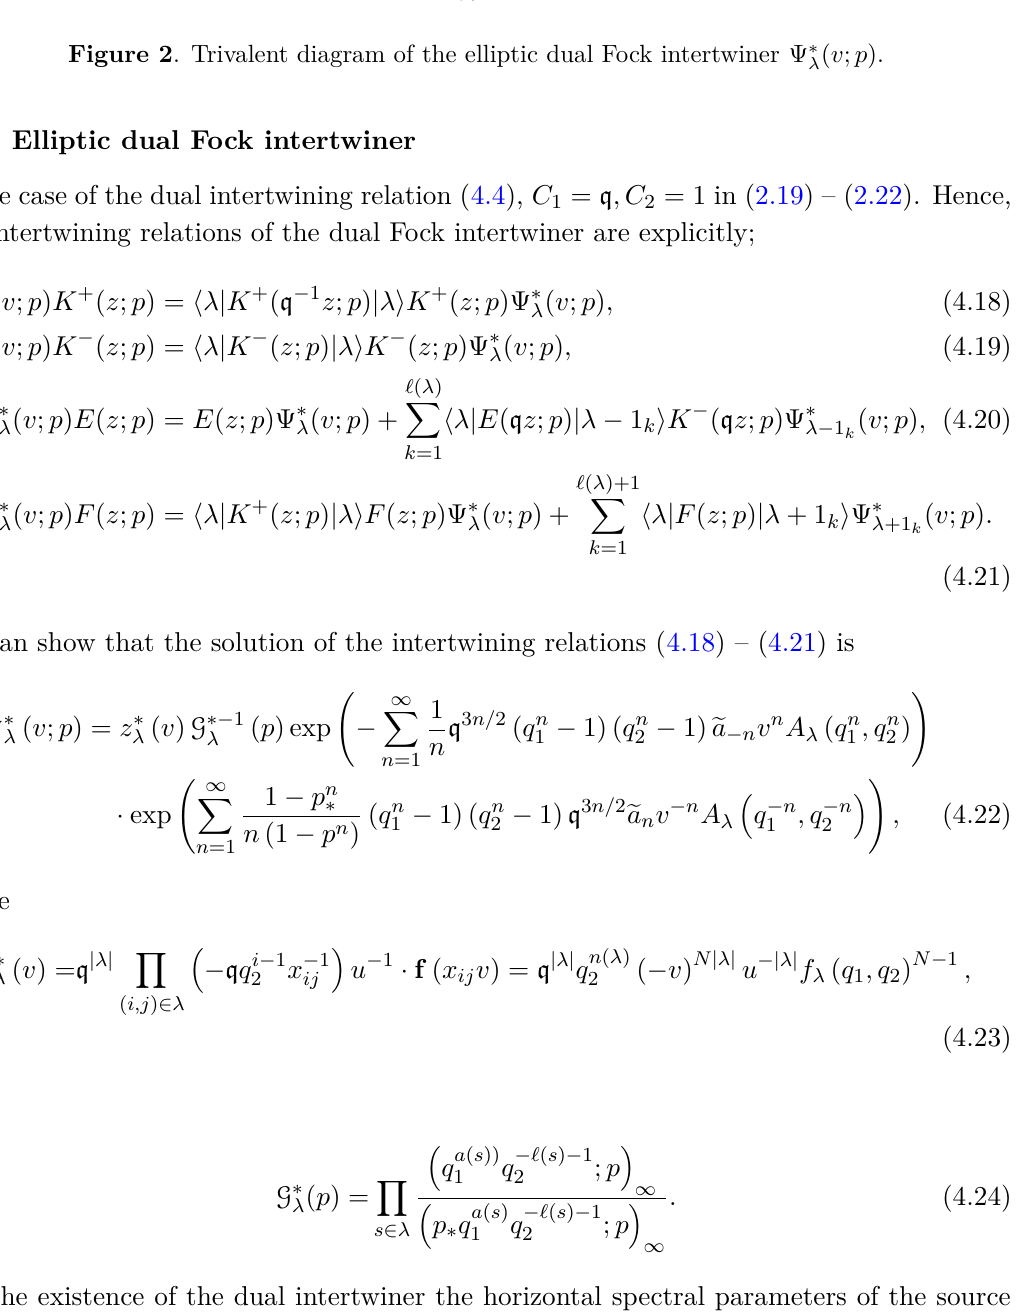
Figure 2 . Trivalent diagram of the elliptic dual Fock intertwiner Ψ ∗